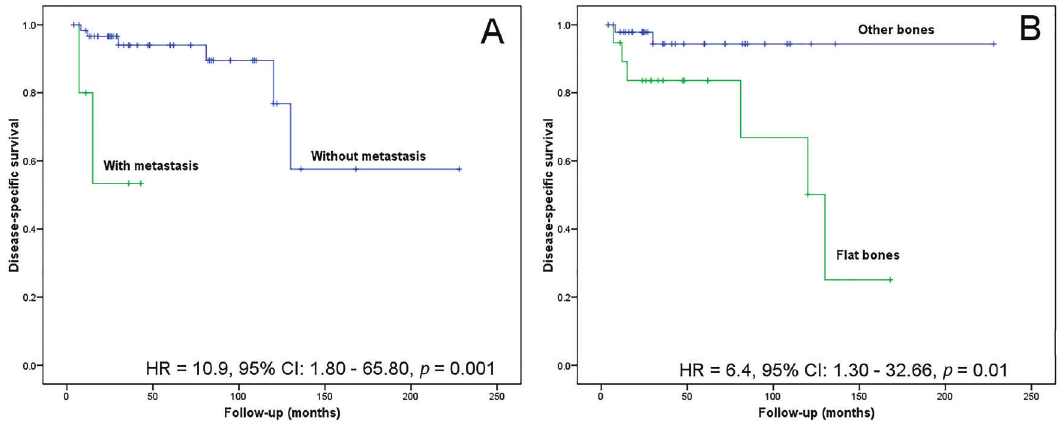
Figure 4 - Kaplan–Meier analysis for disease-specific survival. (A) Patients without metastasis show a greater probability of survival than those with metastasis ( p =0.0010). (B) Patients with tumors located in the appendicular skeleton show a greater probability of survival than those with axial tumors ( p =0.0100).